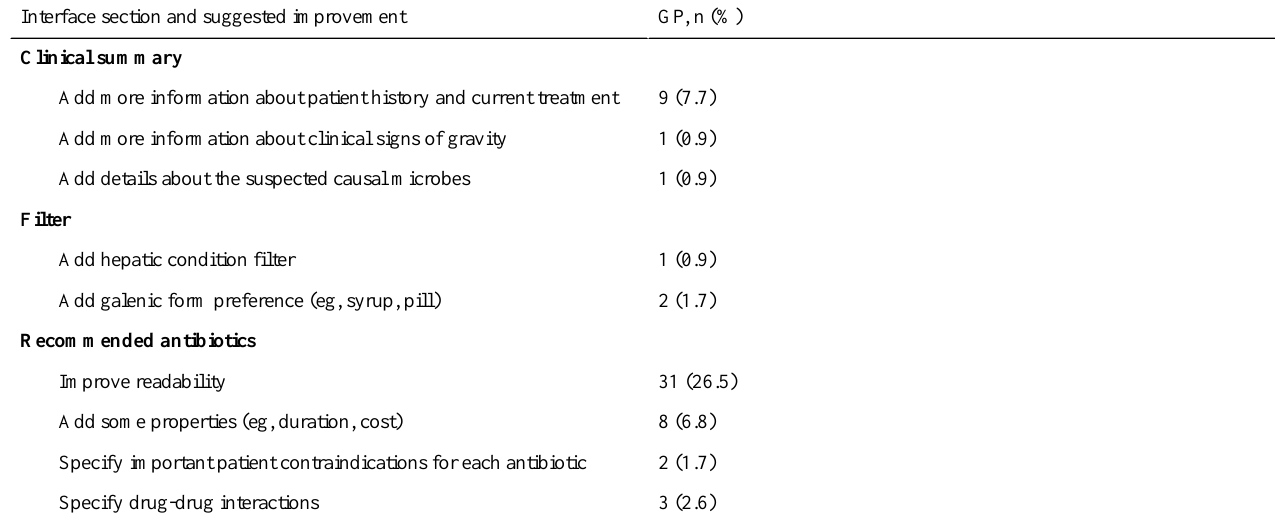
Table 3. Areas for improvement extracted by analysis of free comments by general practitioners (GPs) (N=117).